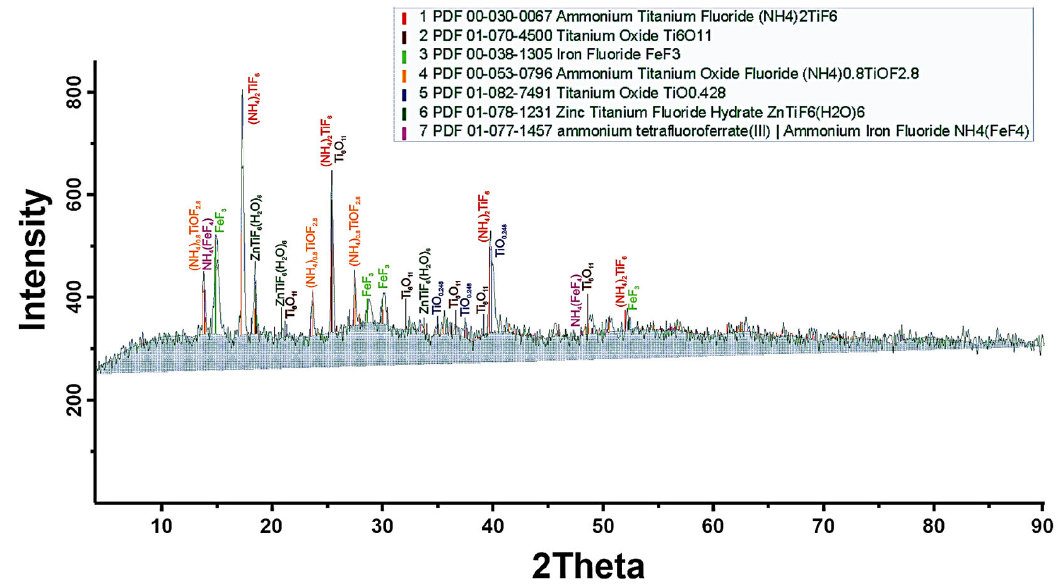
Figure 6. A diffractogram of the residue from fluorination of electrofusion dust of ilmenite concentrate (6 h, 260 ° С , dust : NH 4 HF 2 = 1 : 0.9).